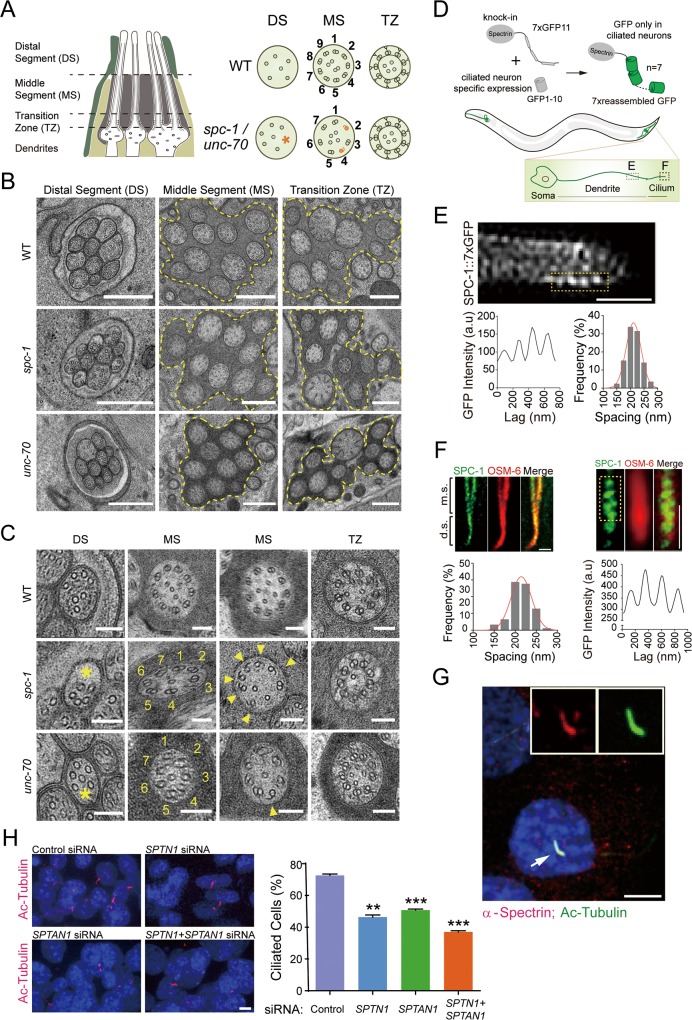
TEM analysis of the ciliary ultrastructure, spectrin localization, and mammalian spectrin in cilia.(A, left) Schematic of the longitudinal ultrastructure of amphid channel cilia (only 4 cilia shown). The glial socket cell (dark green) and sheath cells (light yellow) are shown. (Right) Schematics summarize the traverse ultrastructural phenotypes of cilia from WT (N2), spc-1 (cas971), and unc-70 (cas983) mutant animals. A red asterisk indicates the area lack of axonemal MTs. Incomplete B subfibers are represented in red. (B) Representative TEM images (cross-sections) of the amphid channel cilia (yellow outlines) DS, MS, and TZ in WT and mutants. Scale bar, 500 nm. (C) High magnification images of amphid channel cilia in WT and mutants. Yellow asterisks indicate areas that lack axonemal MTs. Yellow arrowheads indicate incomplete B subfibers in the axoneme. Scale bar, 100 nm. (D, top) Schematic diagram for spectrin fluorescence signal amplification by tandem 7×GFP11 tag, with the specific illumination in C. elegans ciliated neurons by the split scheme. (Bottom) 7×GFP in ciliated neurons and a zoomed phasmid cilium to show the dendrite and cilium segments used for analyzing spectrin periodic structures in (E–F). (E, top) The representative image of SPC-1::7×GFP in the dendrite of a live C. elegans. (Bottom) Corresponding fluorescence intensity of the boxed region (left) and the histogram of the spacings between periodic structure (right, N = 128 spacings). The red line is a Gaussian fit with a mean of 204.4 nm and an SD of 46.6 nm. Scale bar, 1 μm. (F, top) The representative image of SPC-1::7×GFP (green) and mCherry-tagged OSM-6 (red) in phasmid cilia (left); the magnified image of phasmid cilia (right) and the corresponding SPC-1::7×GFP fluorescence intensity of the boxed region (bottom). Histogram of the spacings between spectrin periodic structure in cilia (N = 75 spacings). The red line is a Gaussian fit with a mean of 214.6 nm and an SD of 24.6 nm. Scale bar, 1 μm. (G) Co-localization of mouse α-spectrin and acetylated tubulin immunofluorescence in cilia of IMCD3 cells. DNA was stained with DAPI in blue. (H) α-spectrin (SPTN1 or SPTAN1) knockdown reduced ciliate cell numbers after 48-h siRNA transfection. The number of the cells: control, N = 569; RNAi of SPTN1, N = 286; SPTAN1, N = 402; and SPTN1 + SPTAN1, N = 325. Values, mean ± SD (n = 3). Student t test: **p < 0.01; ***p < 0.001. Scale bars in (G–H), 5 μm. Data associated with this figure can be found in S1 Data. a.u, arbitrary unit; DS, distal segment; GFP, green fluorescence protein; IMCD3, inner medullary collecting duct; MS, middle segment; MT, microtubule; RNAi, RNA interference; siRNA, small interfering RNA; TEM, transmission electron microscope; TZ, transition zone; WT, wild type.